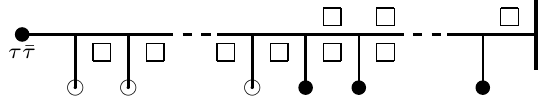
Figure 15 . The basis when both (cid:28) (cid:22) (cid:28) (